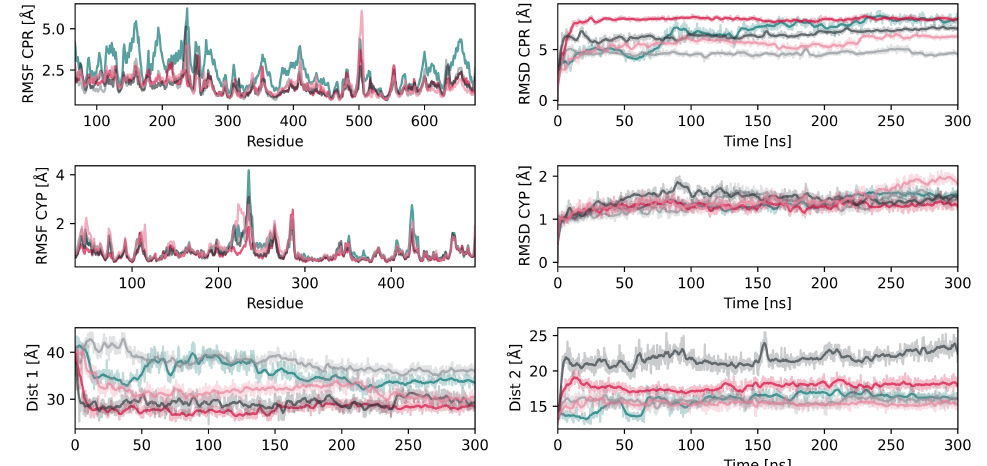
Figure 3. Metrics of the CPR–CYP2D6 unliganded complex simulations conducted with five replicas. The RMSD and RMSF of each protein are presented along the distance between FAD and FMN (denoted as Dist 1) and between the heme and FMN (denoted as Dist